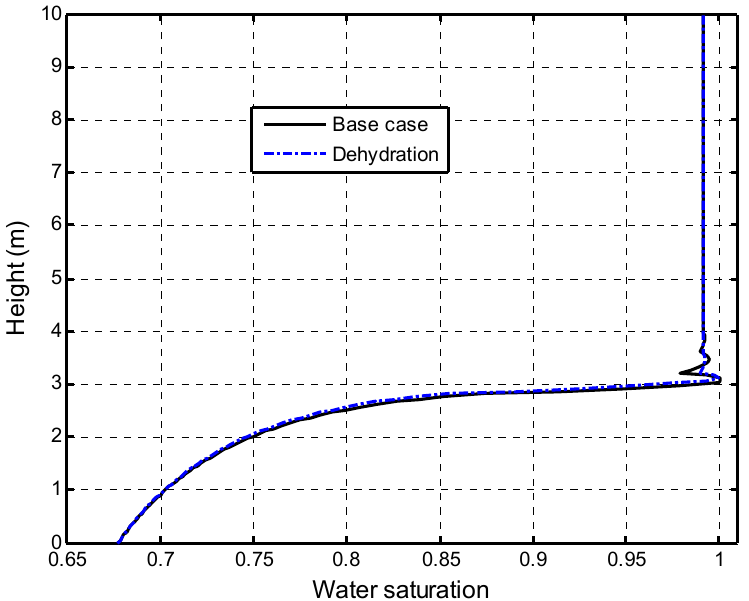
Figure 9. Effect of dehydration on the water saturation in fracture network at 317 years.